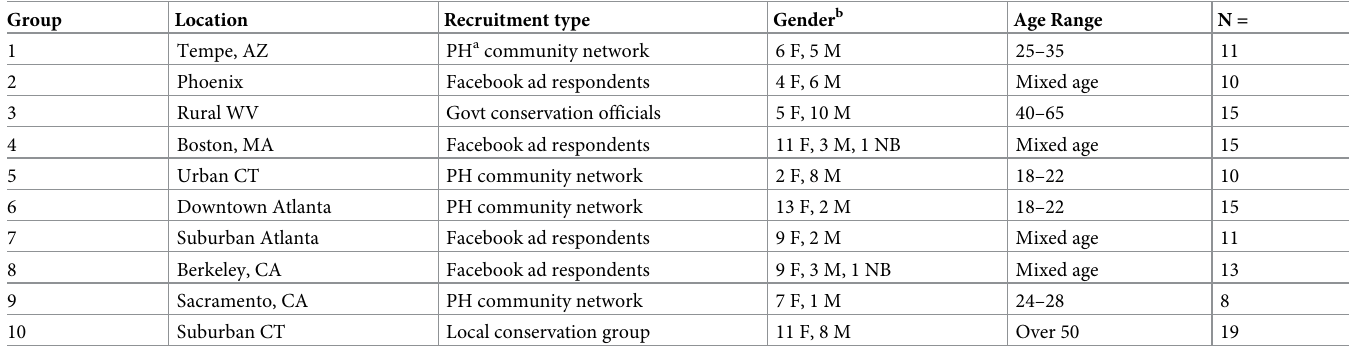
Table 1. Focus groups